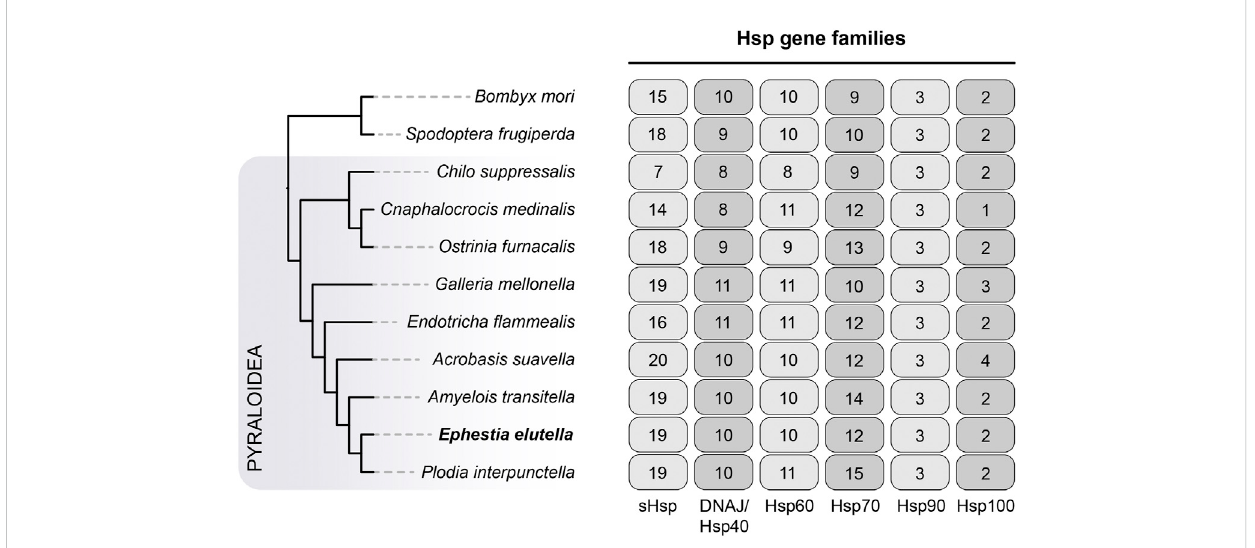
FIGURE 5 Evolution of Hsp gene families in Pyraloidea. The phylogenetic relationship of the analyzed species (nine Pyraloidea species and two outgroups) is directly obtained from Figure 3. The gene numbers for six Hsp subfamilies, including sHsp, DNAJ/Hsp40, Hsp60, Hsp70, Hsp90, and Hsp100, are indicated on the